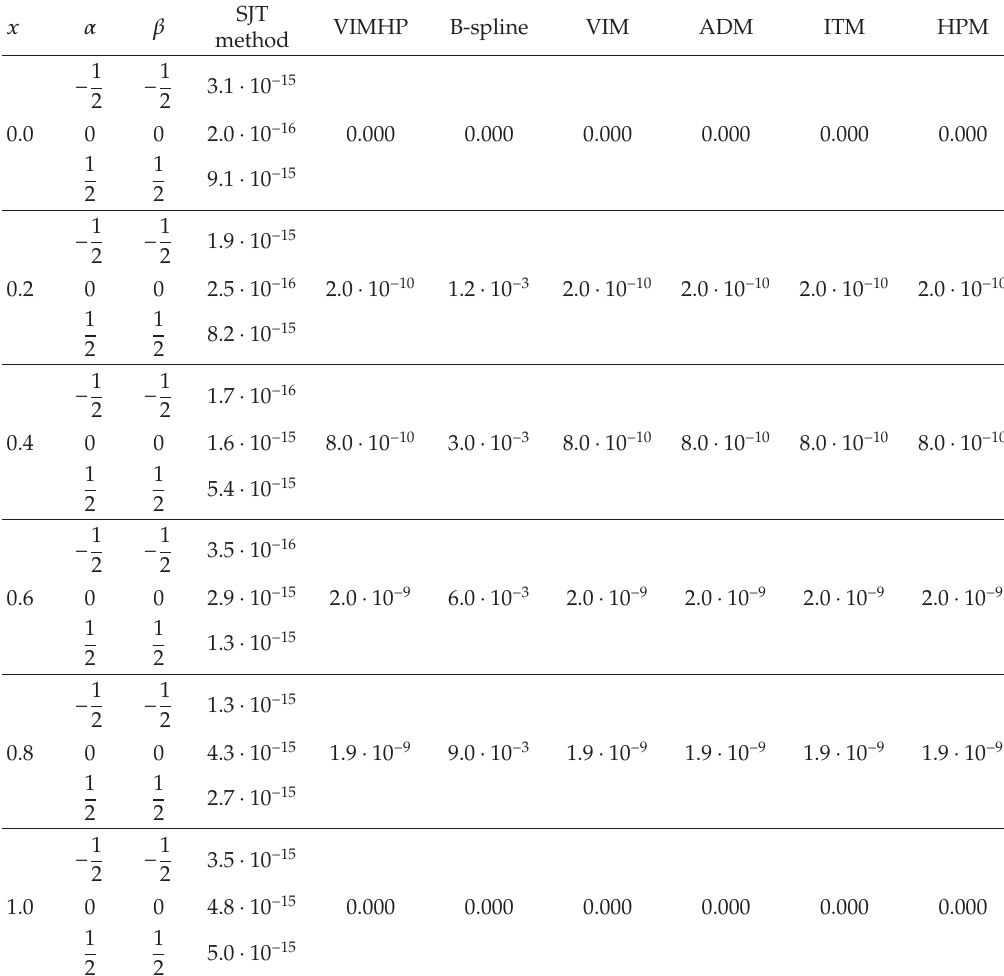
Table 1: Absolute errors using SJT method for N (cid:8)